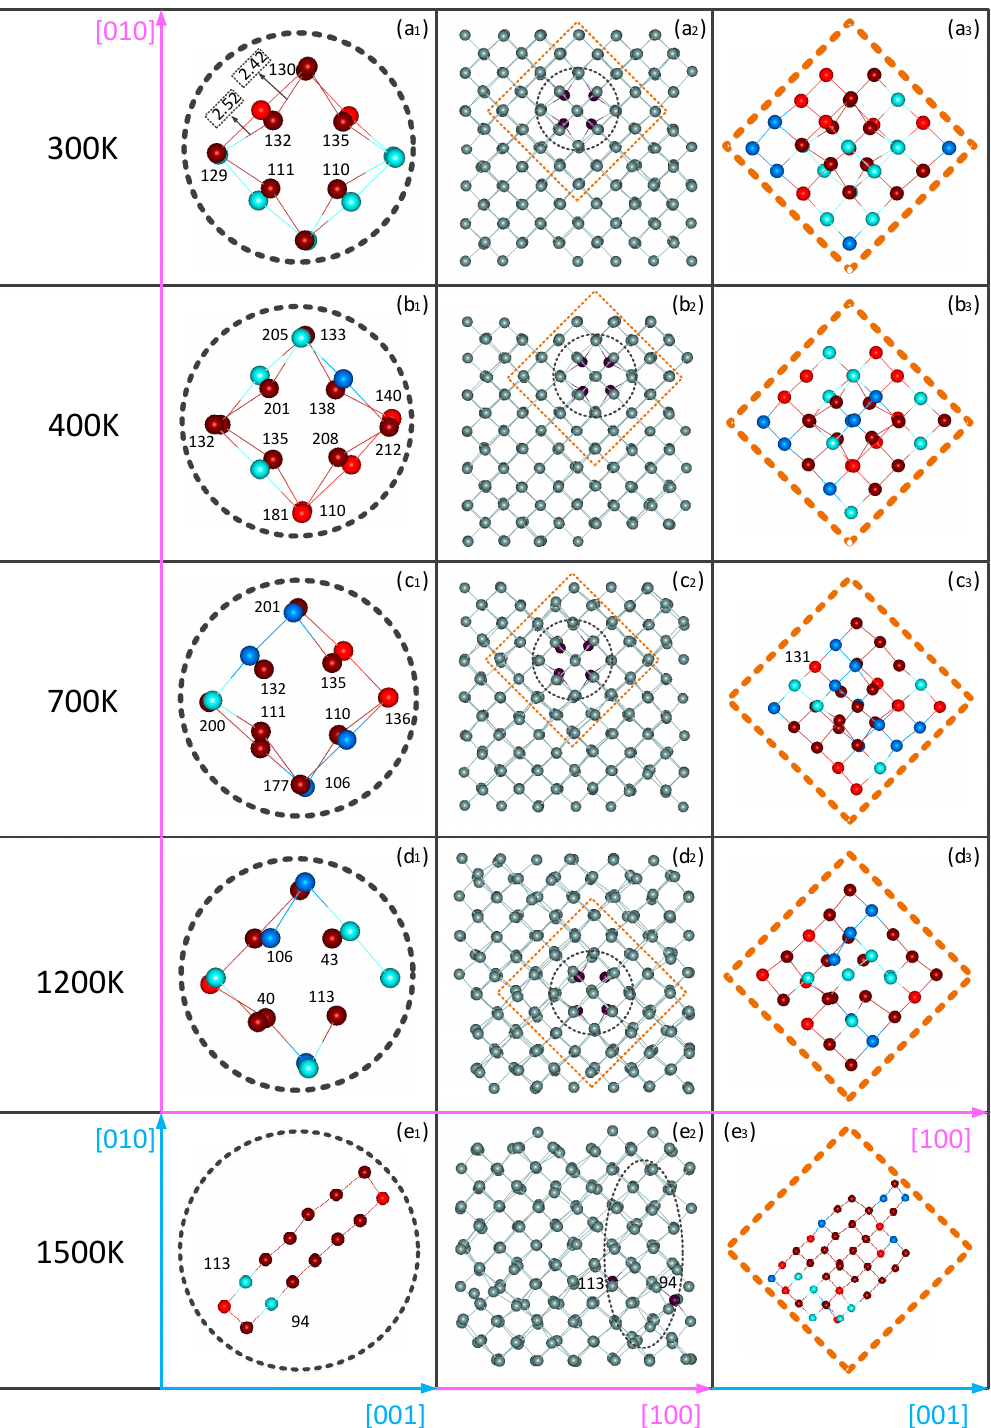
Figure 4. The atomic packing structure and the pressure distribution of Si lattice with one vacancy at different temperatures: ( a 1 – a 3 ) 300, ( b 1 – b 3 ) 400, ( c 1 – c 3 ) 700, ( d 1 – d 3 ) 1200 and ( e 1 – e 3 ) 1500 K; the black dotted line shows the packing structure and the pressure of the nearest neighbor atoms of vacancy, while the orange dotted line shows the packing structure and the pressure of the atoms neighboring the vacancy; the red atoms in this figure indicate that the atom undergoes compression, and the pressure is positive. The atomic pressure of dark red atoms is higher than that of light red atoms. Blue atoms are stretched, and the pressure is negative. Dark blue color indicates atoms that are under less pressure than light blue atoms.